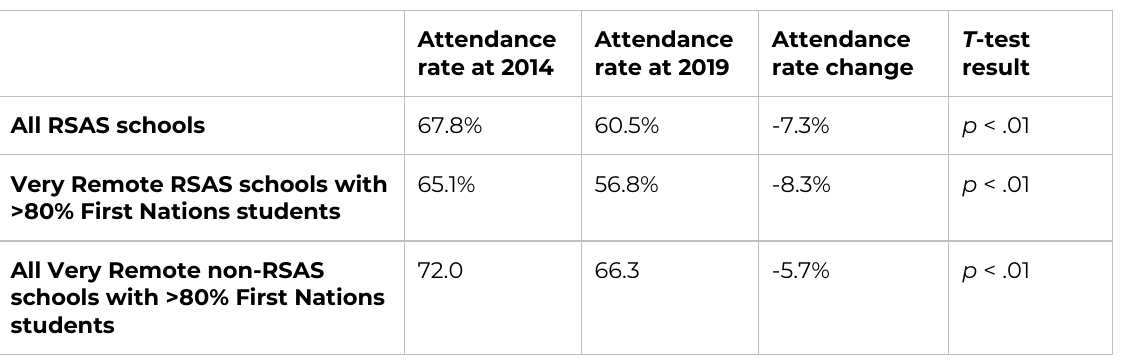
Table 1: Term 1 school attendance rates for RSAS schools and comparable Very Remote non-RSAS